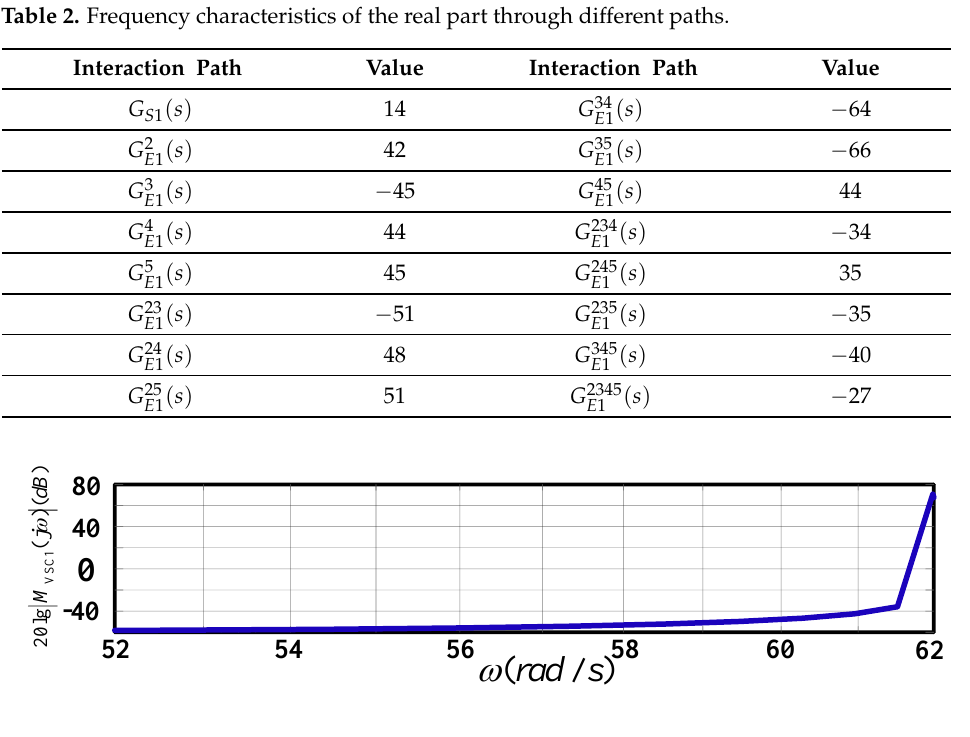
Figure 6. Frequency characteristics of M VSC 1 ( s )